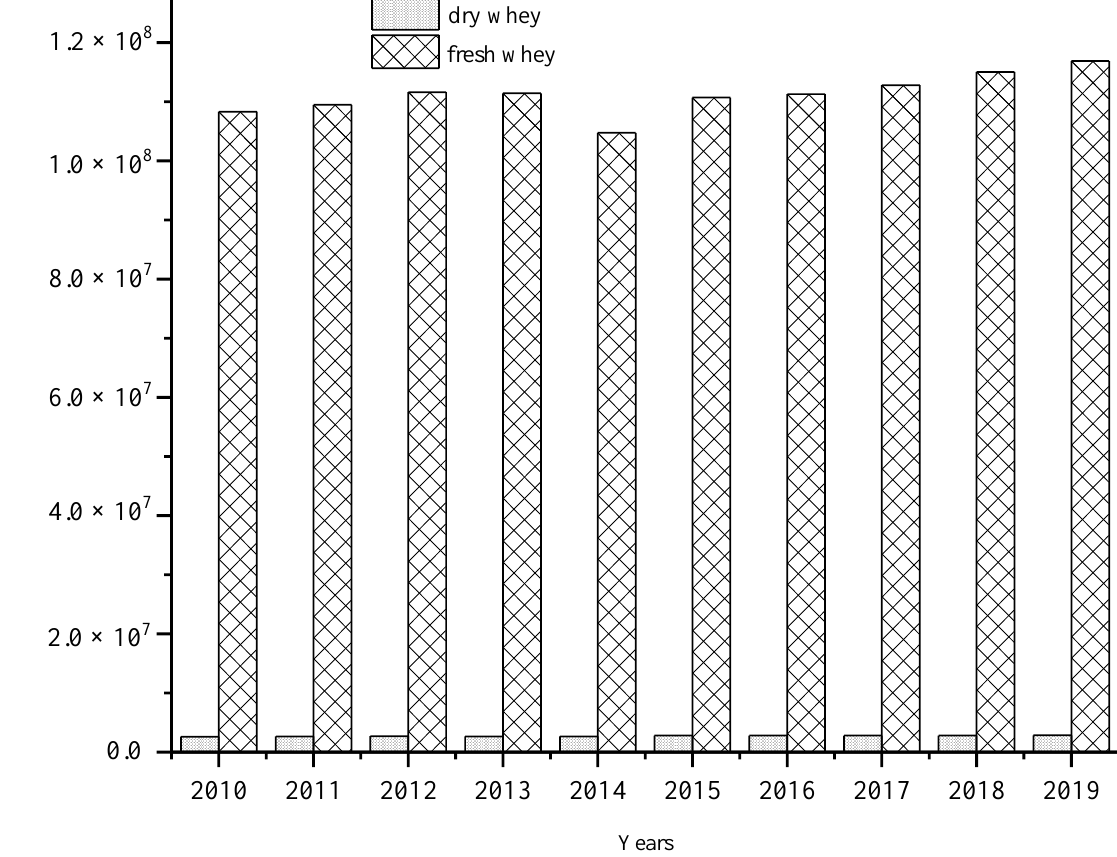
Figure 1. Worldwide production of dry whey and fresh whey from 2010 to 2019 (FAOSTAT, 2022).